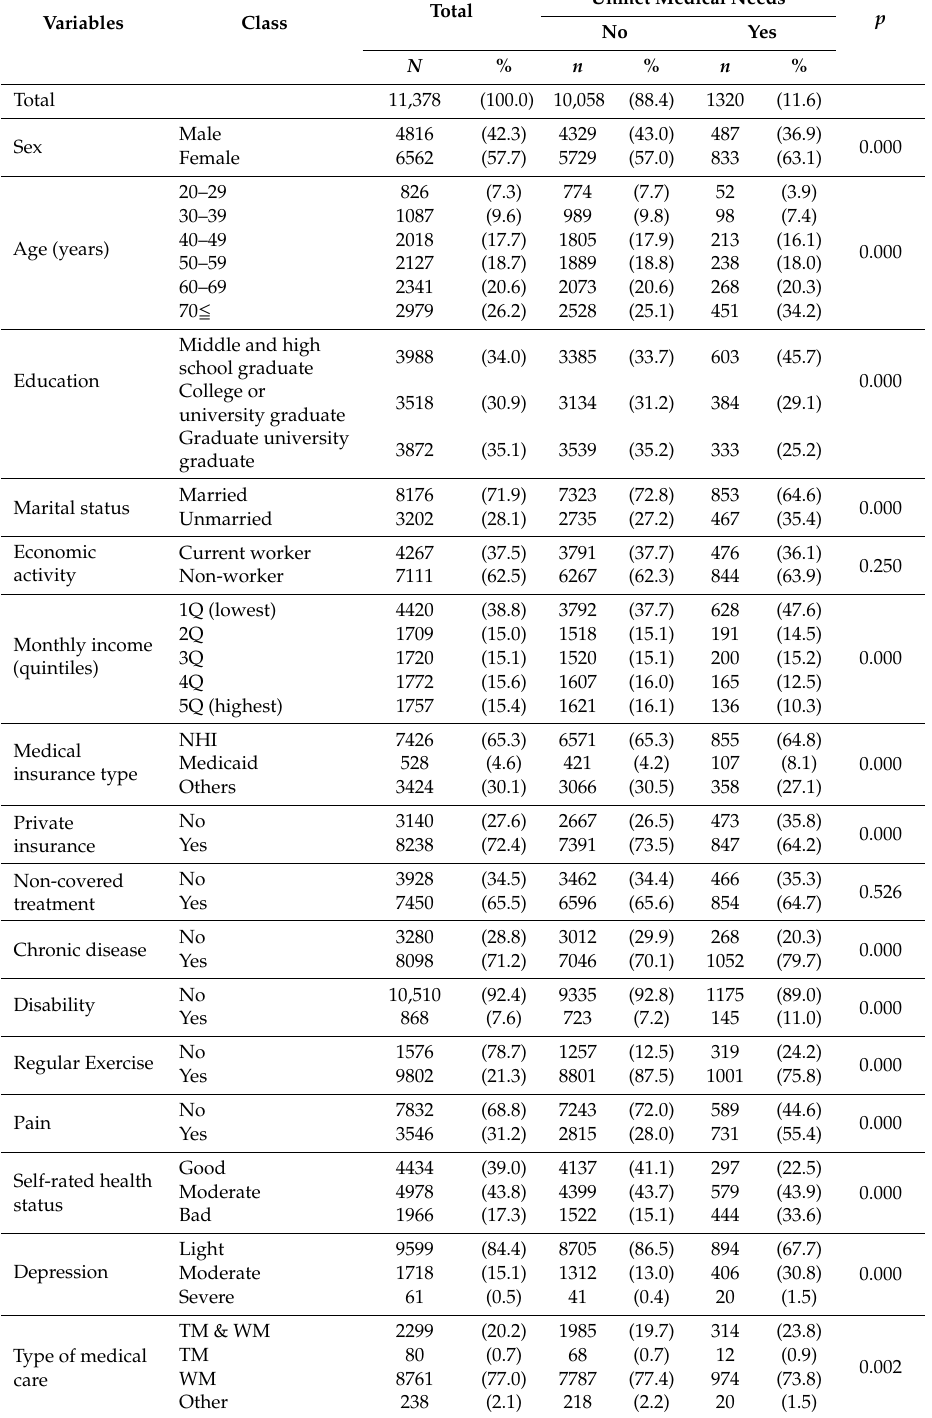
Table 1. Presence of unmet medical needs according to sociodemographic characteristics of